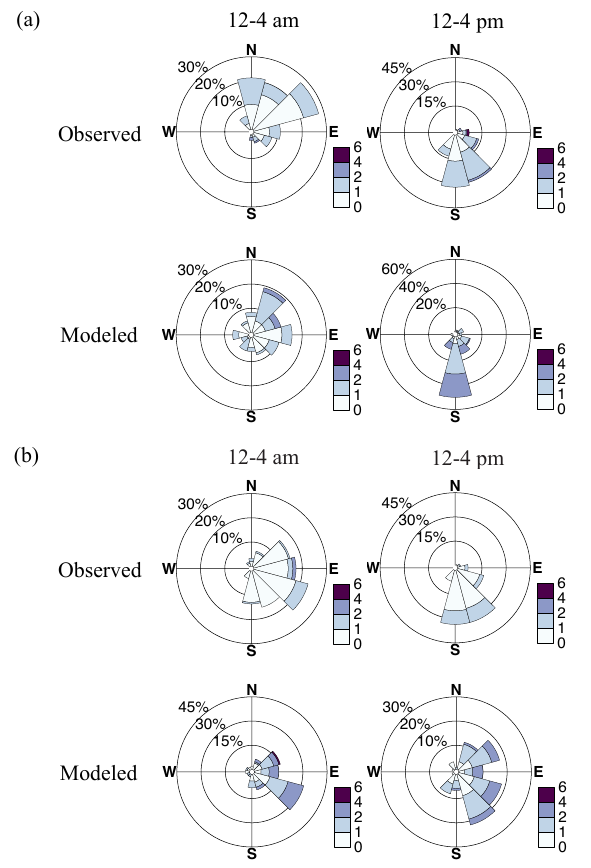
Fig. 3. Wind roses showing percentage of time with given wind direction and speed (color bar, m s − 1 ). Observed (15 ma.g.l.) and modeled (500 ma.g.l.) wind roses for 00:00–04:00 and 12:00–16:00 for (a) January 2012 and (b) July